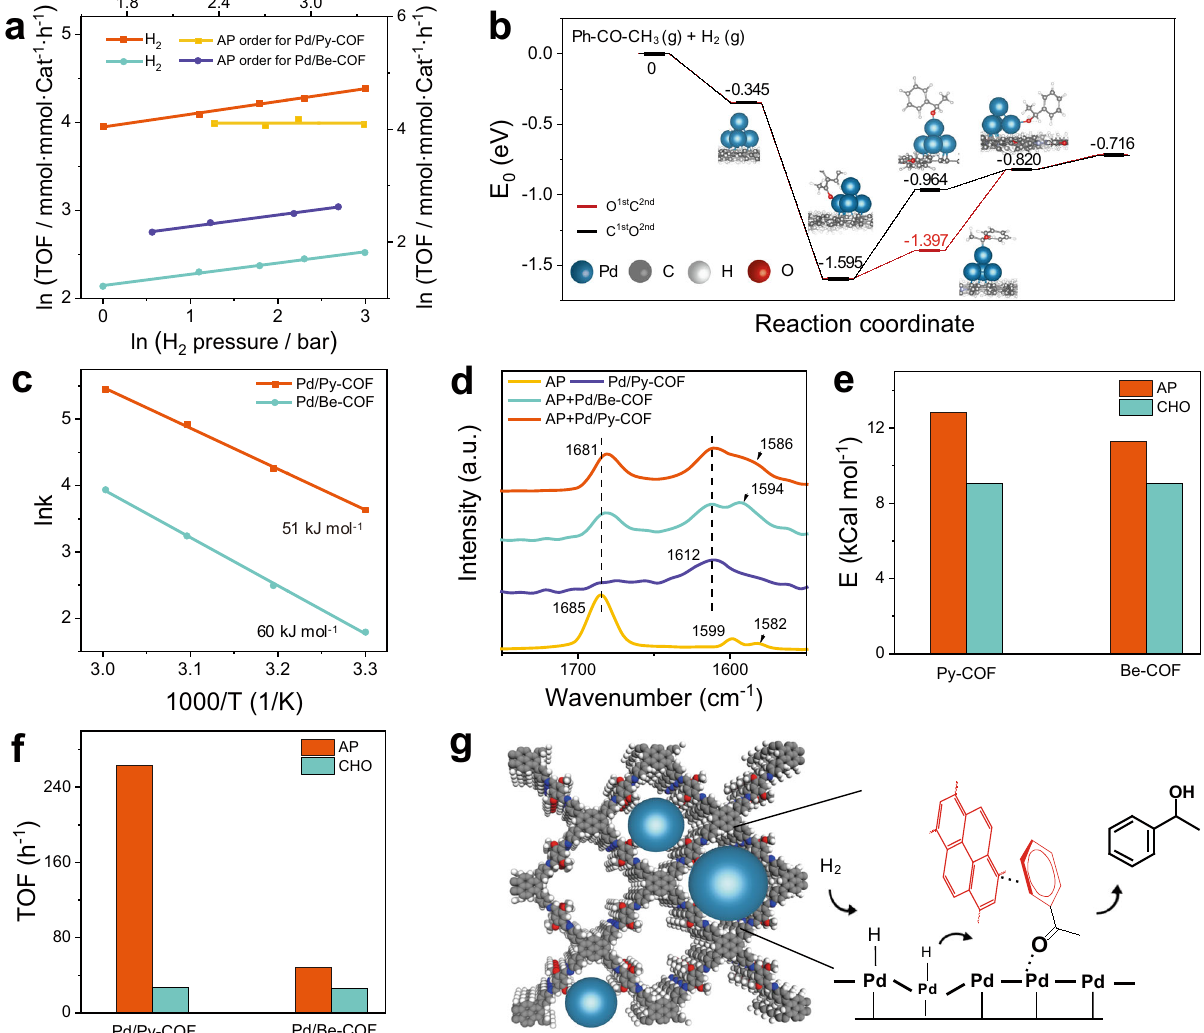
Fig. 4 Mechanism investigation. a Reaction orders with respect to H 2 and AP on Pd/Py-COF and Pd/Be-COF. b Potential energy pro fi les for carbonyl hydrogenation of AP with different sequences (O1st C2nd and C1st O2nd). c Arrhenius plots showing apparent activation barriers for Pd/Py-COF and Pd/ Be-COF. d FT-IR spectra of AP, Pd/Py-COF and AP absorbed on Pd/Py-COF and Pd/Be-COF. e The interaction energies between COFs and AP/CHO. f TOFs of AP and CHO hydrogenation on Pd/Py-COF and Pd/Be-COF. g Schematic diagram of Pd NPs con fi ned in Py-COF and proposed reaction mechanism of AP hydrogenation on Pd/Py-COF. (Reaction conditions for a : 40 °C, 2 mL of EtOH, H 2 pressure varies from 1 to 20 bar, AP concentration varies from ∼ 7 to ∼ 28 mg/mL. The TOF values for Arrhenius plots in c were recorded at 30, 40, 50 and 60 °C. Reaction conditions for f : 130 °C, 20 bar of H 2 , 0.07 mmol of CHO, Pd catalysts 4 mmol%, 2 mL of H 2